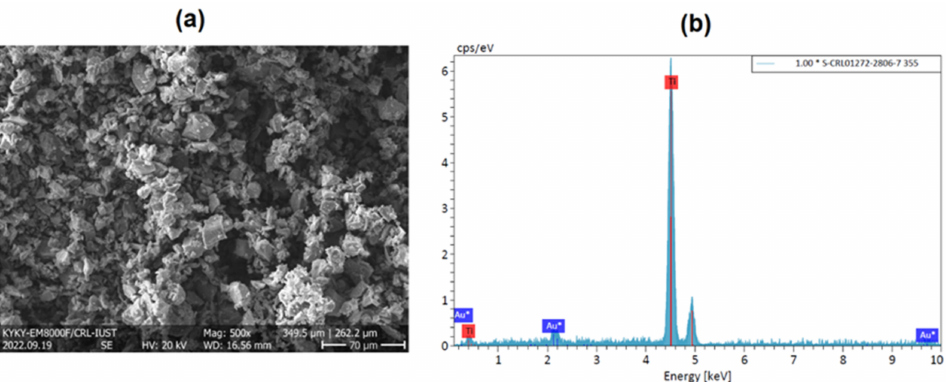
Figure 1. ( a ) SEM micrographs of a received TiH 2 powder and ( b ) its EDX analysis.